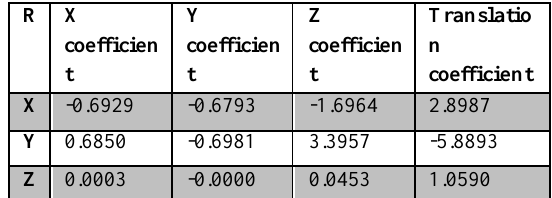
based on the least square adjustment (Absolute orientation) using the Leica C10 data were calculated (see Table